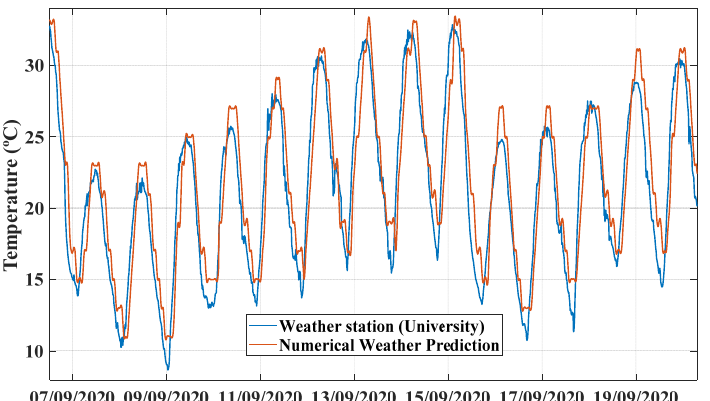
Figure 2. A comparison between the ambient temperature measured at the station and the temperature obtained from the AEMET website.